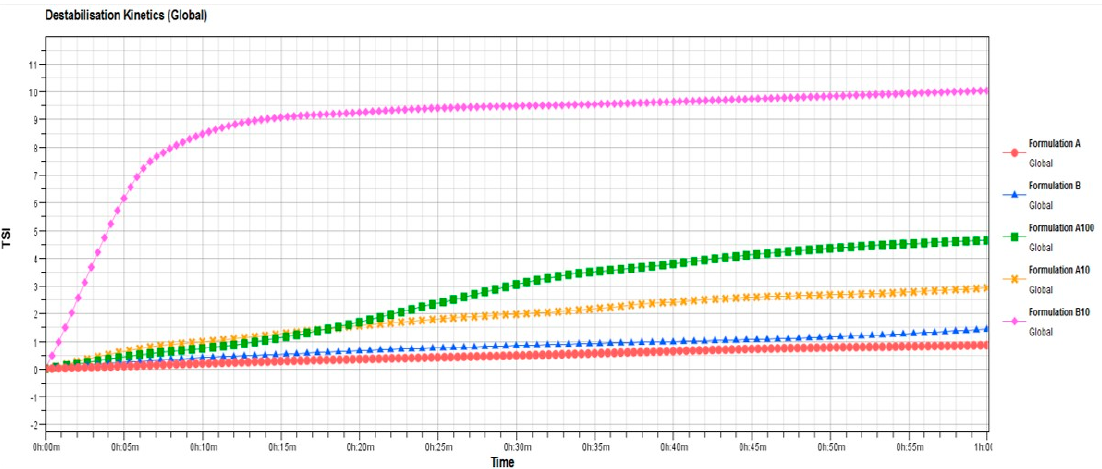
Figure 8. Turbiscan Stability Index (TSI) profiles of blank ufasomes and oleuropein-loaded ufasomes, obtained by Turbiscan Lab Expert ® . The result was a representative of three independent experiments.